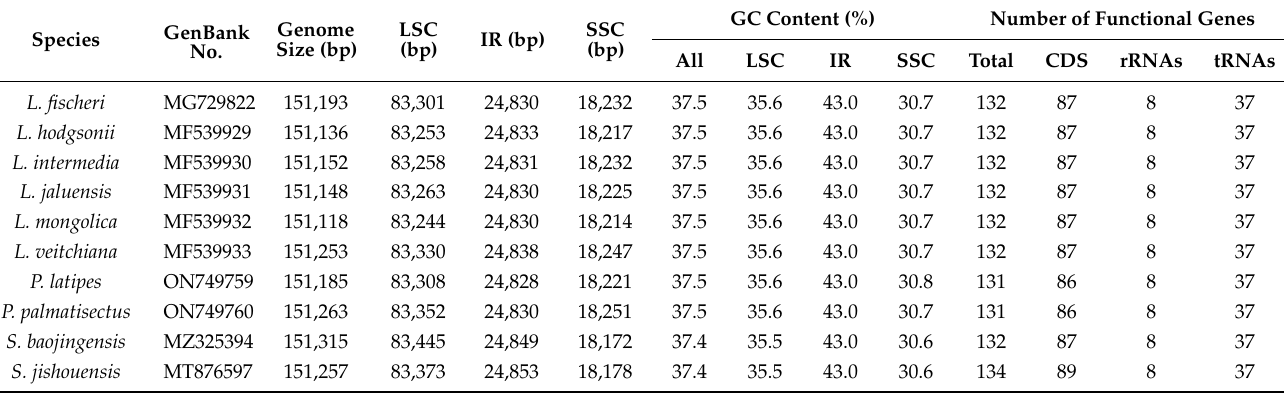
Table 1. Comparative analyses of cp genomes among 10 species of